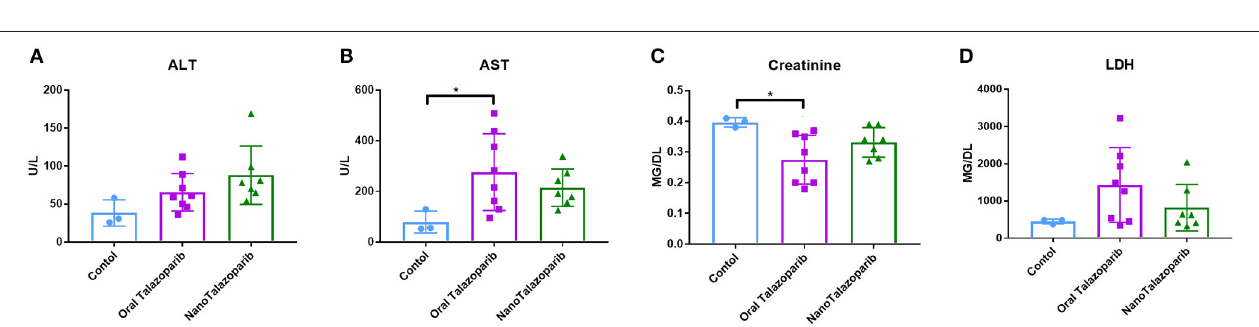
FIGURE 6 | Comparison of serum levels of (A) ALT, (B) AST, (C) Creatinine, and (D) LDH following no treatment ( n = 3) or treatment with 3 doses of either oral Talazoparib ( n = 7) or NanoTalazoparib ( n = 8); Statistical significance was determined using one way ANOVA followed by Tukey’s test, * p < 0.05 vs. control.